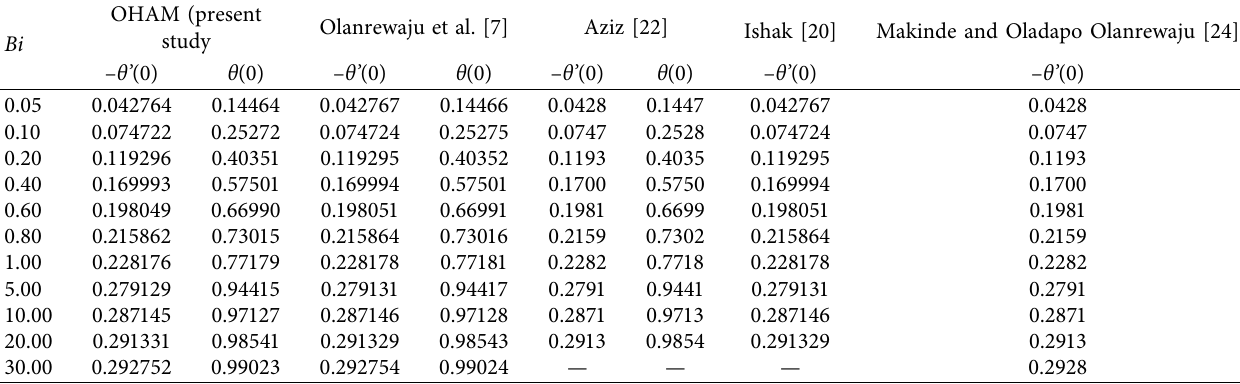
Table 1: A comparison of the values obtained for the Nusselt number and surface temperature with an increase in the local Biot number in this study and by Olanrewaju et al., Aziz, Ishak, and Makinde and Oladapo Olanrewaju in previous studies.